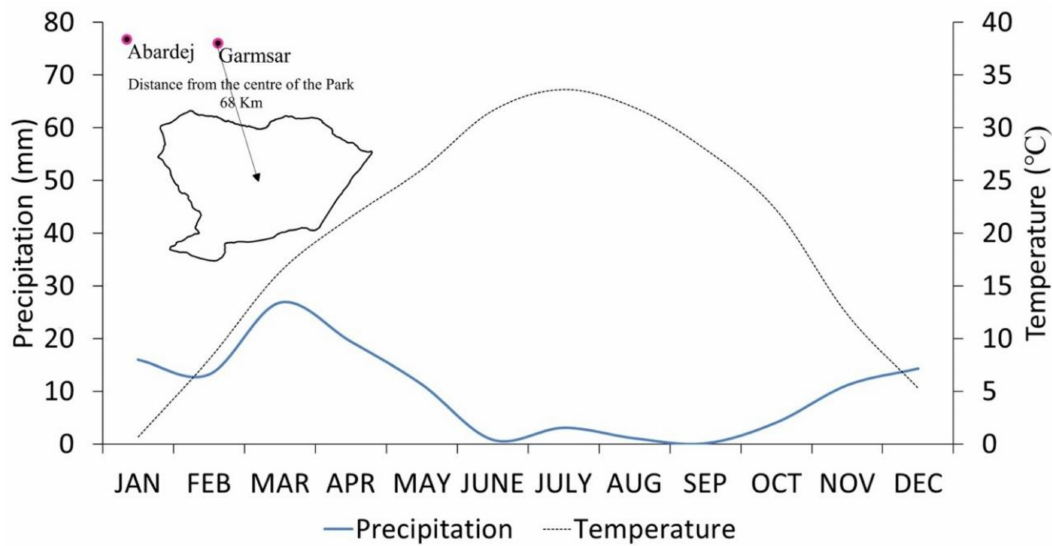
Figure 2. The Ombrothermic Diagram of Garmsar as the closest weather station to the Kavir National